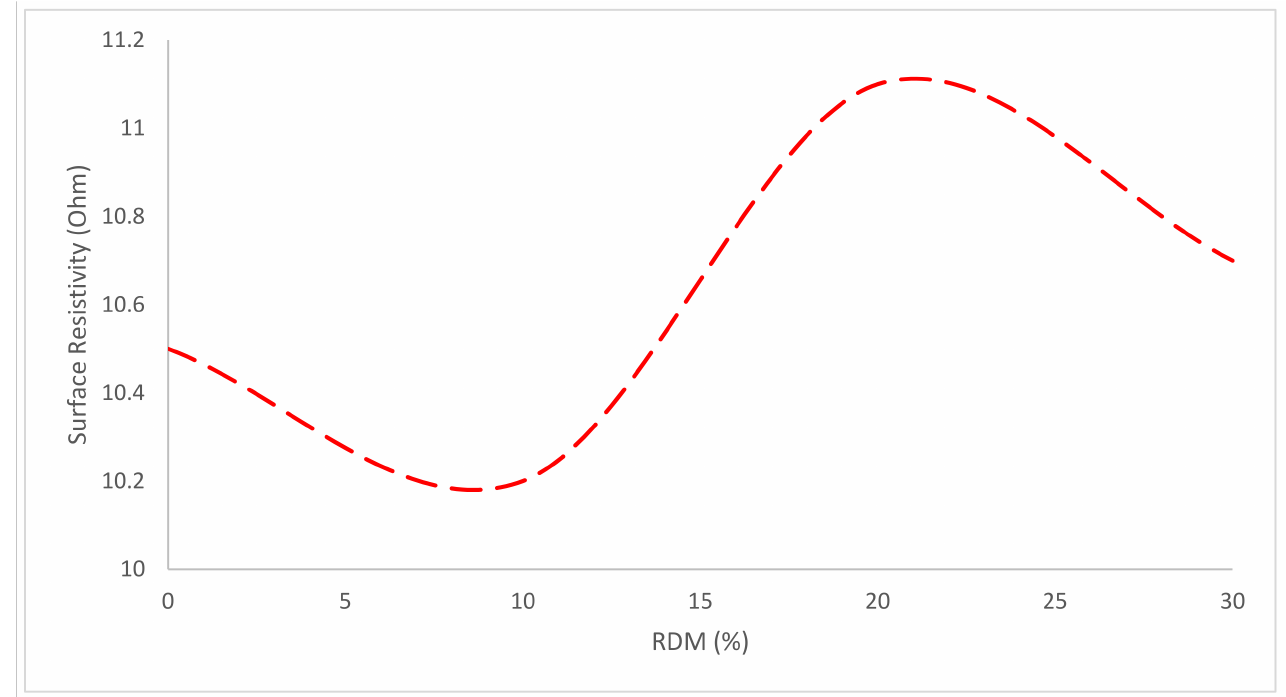
Figure 18. Surface Resistivity